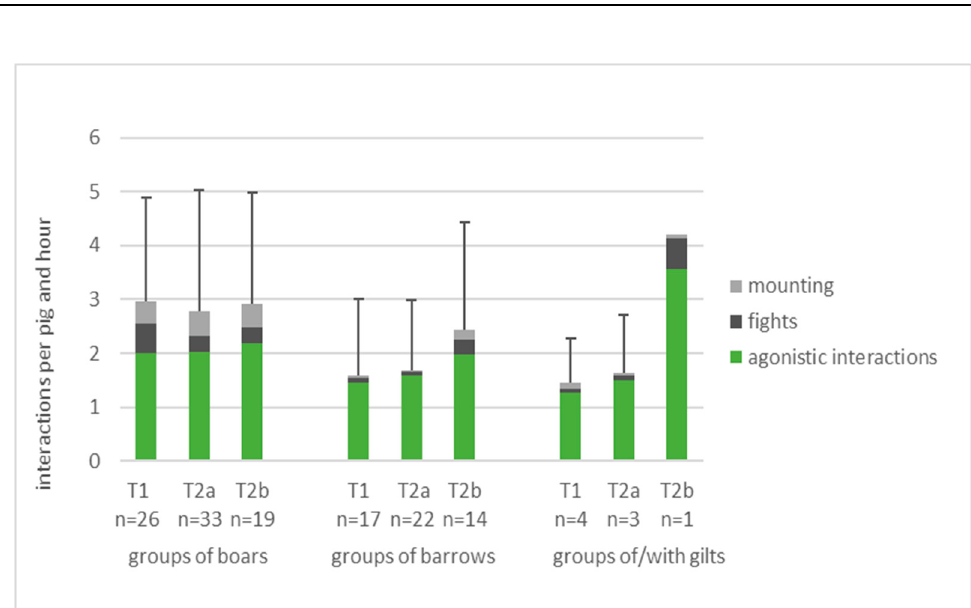
Figure 2. Social interactions per pig and hour in 41 groups of boars, 26 groups of barrows and 6 groups of gilts only or with gilts and barrows at three observation points (T1: mean pig weight around 80 kg, T2a: first pigs with ca. 120 kg, T2b: within 48 h after first split-marketing; n = number of observed groups per observation point).